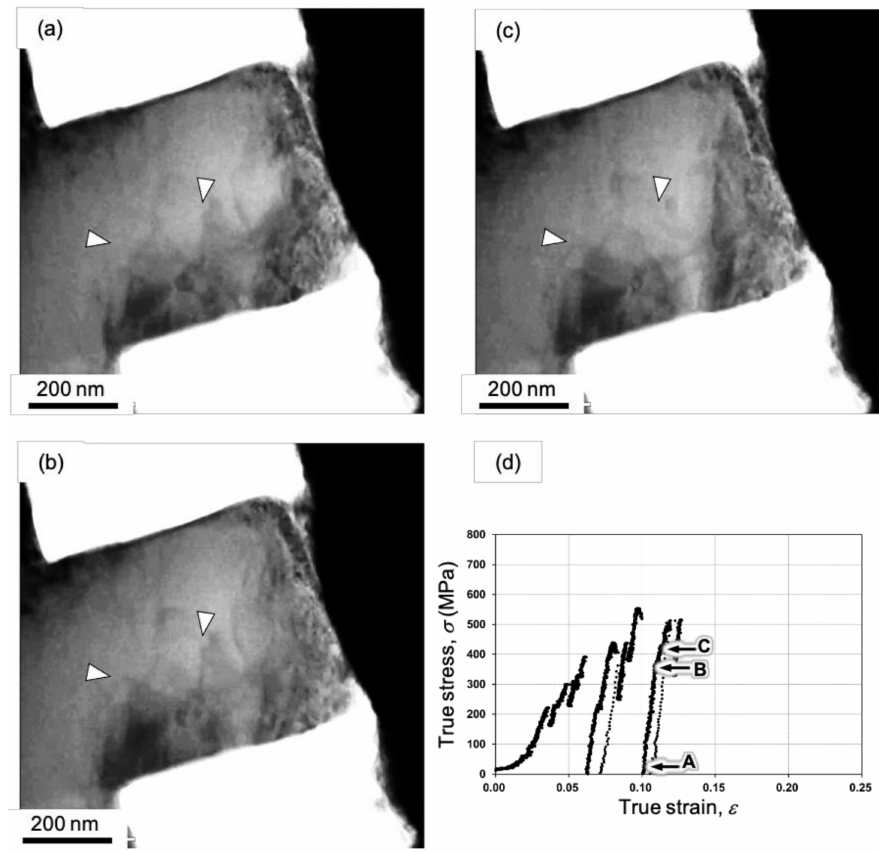
Figure 8. ( a – c ) Series of snapshots during the reloading process captured during TEM in situ compression of the post-annealed Al pillar. The images in ( a – c ) correspond to points A–C on the S–S curve in ( d ), respectively. At the points indicated by the arrowheads, the change in the contrast due to the motion of the dislocations are seen. This change is seen in the supplementary video (S3). A possible reason for the reloading process being macroscopically dominated by elastic deformation even though the dislocations were moving is as follows. TEM in situ straining was performed in displacement control mode with a constant nominal